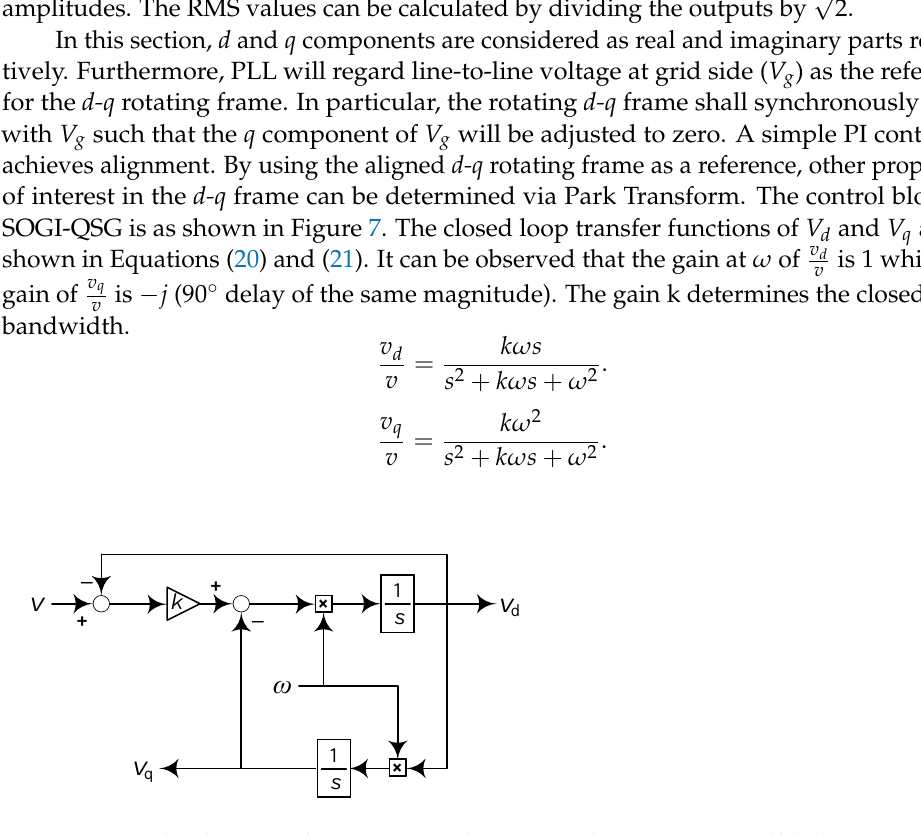
Figure 7. Second-order-general integrator quadrature signal generator control